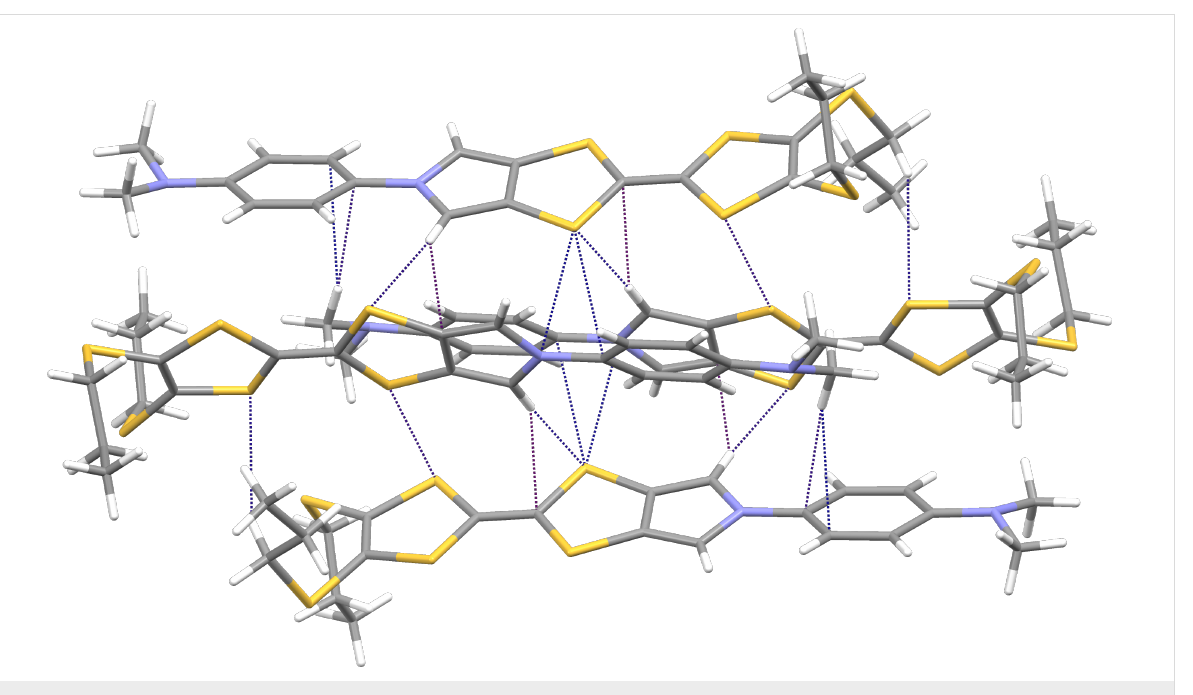
Figure 8: Crystal packing of 4e showing a group of four molecules interconnected by multiple weak hydrogen bonds, C–H··· π , and S···S close